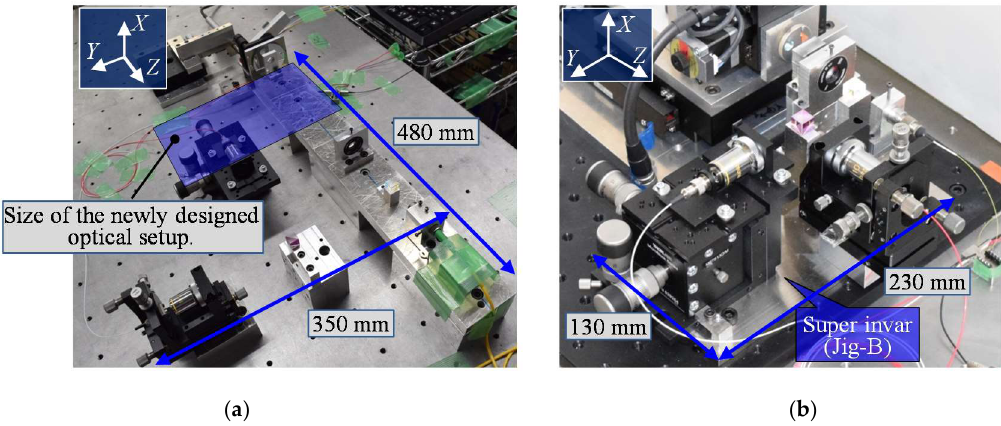
Figure 11. Comparison of the size of the previous first prototype measurement setup with that of the newly designed second prototype measurement setup: ( a ) A photograph of the previous first prototype measurement setup; ( b ) A photograph of the newly designed second prototype measurement setup. Table 4. Theoretically estimated thermal stabilities of the previous first prototype probe and the newly designed second prototype